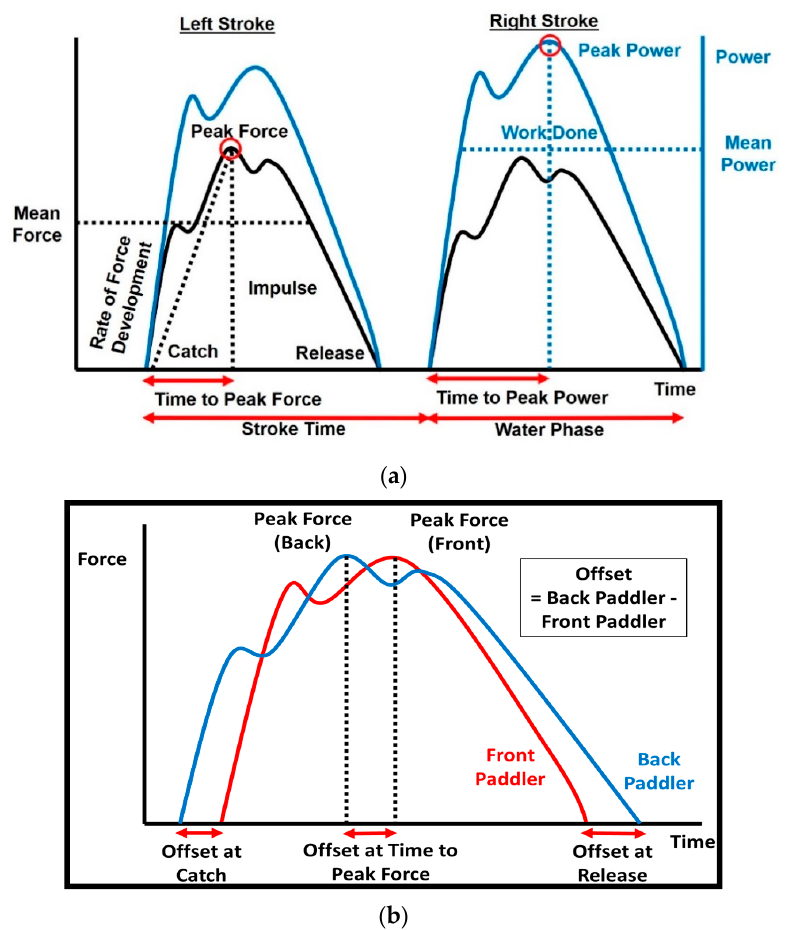
Figure 4. Extraction of key variables of interest for each stroke: ( a ). force, power, and temporal variables for each individual paddler; ( b ) timing offset variables between the front and back paddlers.